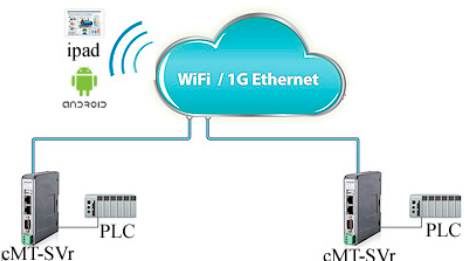
Figure 7. Block diagram of IOS/Android controlling unit.